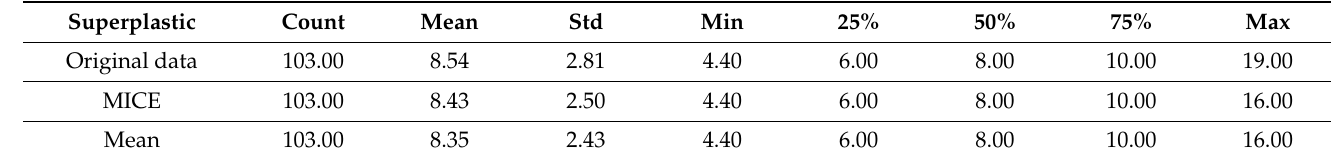
Table 4. Mean replacement, MICE replacement, effect comparison.